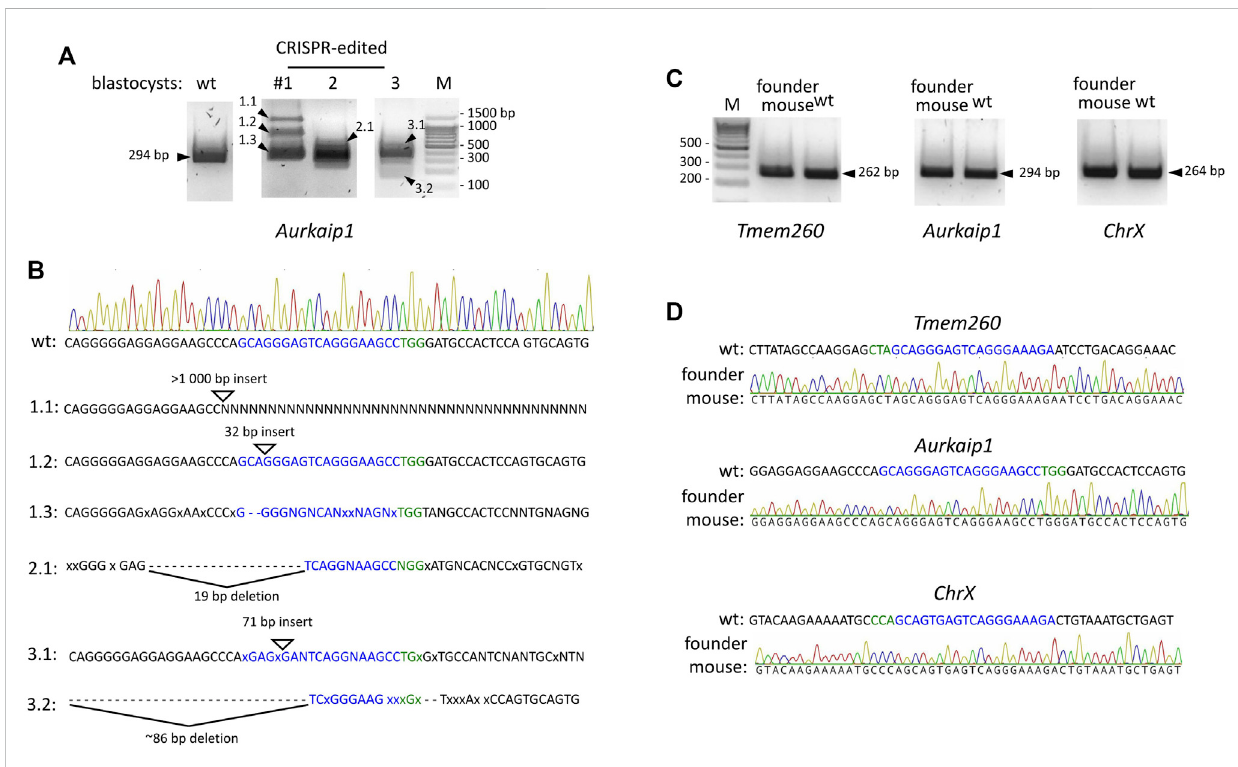
FIGURE 5 CRISPR/Cas9 off-target activity in microinjected embryos and genome-edited Gnao1-GGA mice. (A) Off-target modi fi cations in the Aurkaip1 coding region analyzed in the microinjected (#1 – 3) and untreated, wild-type blastocysts. The Aurkaip1 genomic region with the putative off-target site was ampli fi ed by PCR, and amplicons were analyzed in agarose gel. Amplicons of various sizes (marked by arrowheads) were subjected to Sanger sequencing. (B) Interpretation of the histograms revealed the mosaic nature of the sequences. Presented are the alternative to wild-type allele sequences characterized by indels. sgRNA off-target sequence and PAM are shown in blue and green respectively, mismatches are shown as “ x, ” deletions as “ -, ” unspeci fi ed nucleotides as “ N. ” (C) Predicted off-target sites were analyzed in the CRISPR-edited genomic material from the founder Gnao1-GGA mice. Genomic regions encompassing off-targets in Aurkaip1 (294 bp), Tmem (262 bp), and ChrX (264 bp) were ampli fi ed and analyzed in agarose gel. A single band of the expected size was detected for each amplicon. (D) Absence of off-target cleavage in founder Gnao1-GGA mice